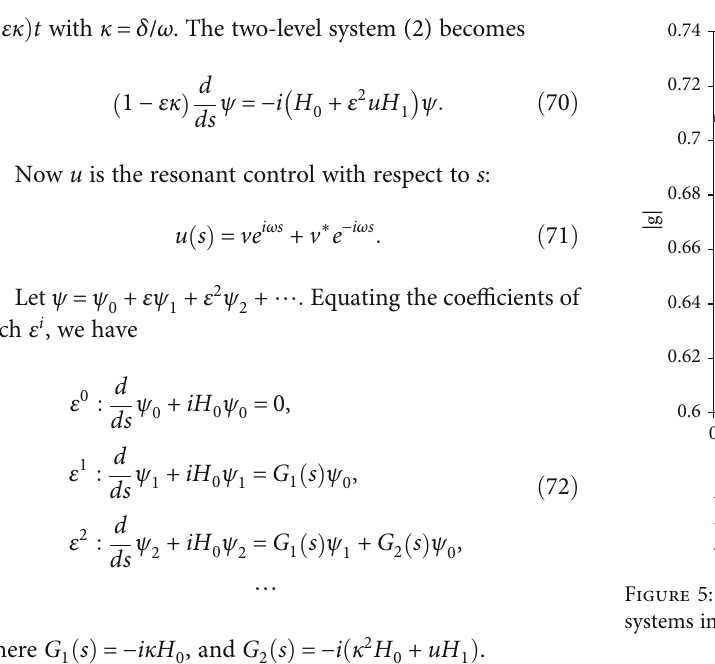
ffiffiffi p 2 /2 Þ . Let λ e